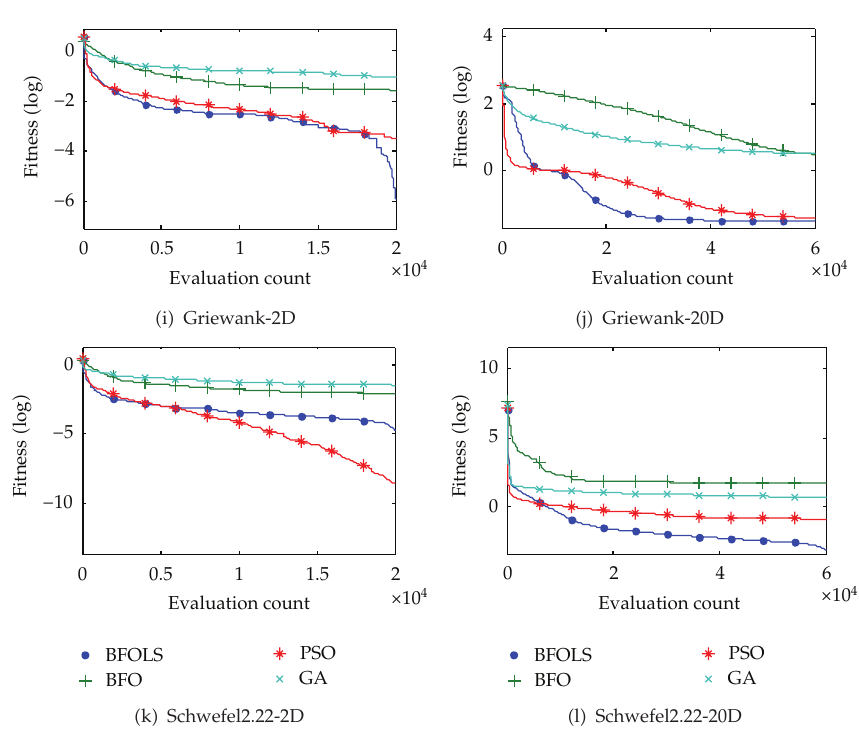
Figure 3: Convergence plots of BFOLS, BFO, PSO, and GA on functions f 1 – f 6 with dimensions of 2 and 20.